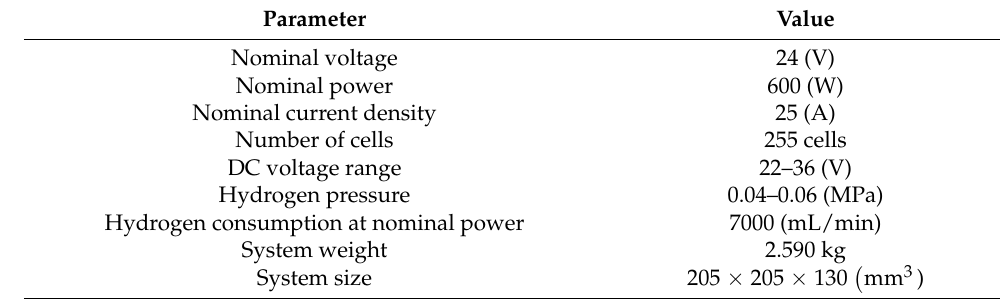
Table 2. The specification of the utilized PEMFC in the suggested integrated system for the UAV.